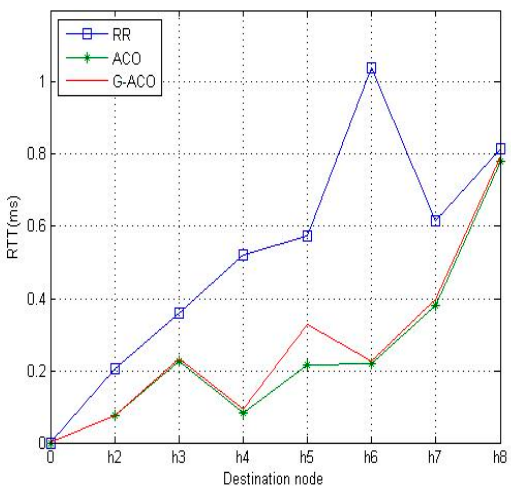
Figure 7. The comparison of RTTs with 5-minute simulation time.